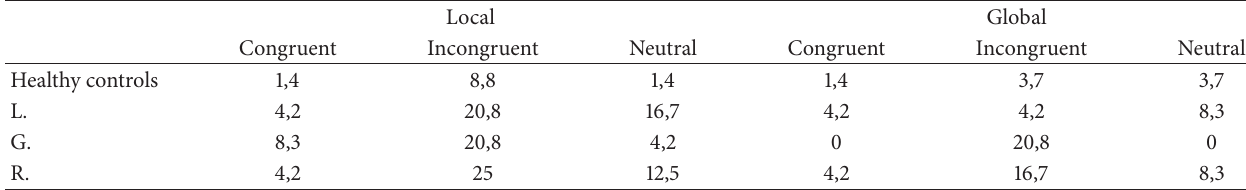
Table 2: Percentage of error for responses in the Navon task by local and global